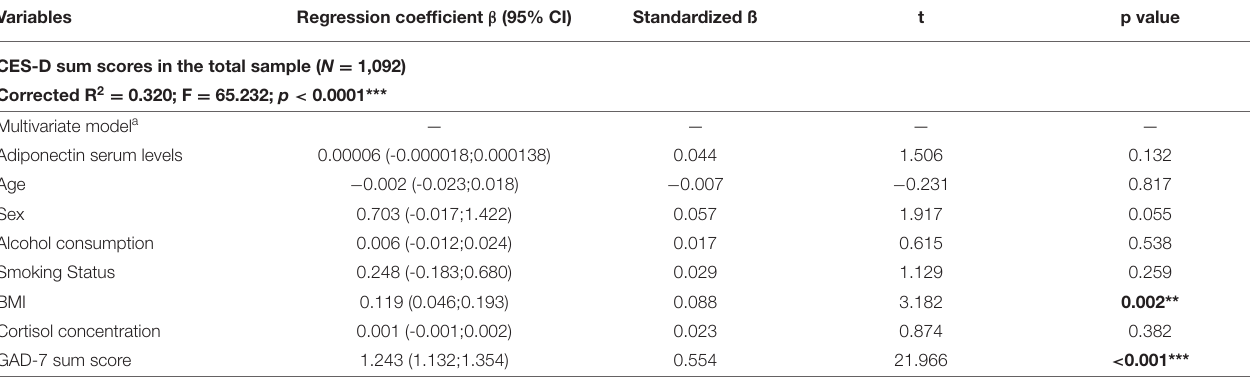
TABLE 3 | Results of multiple linear regression analyses regarding the association between adiponectin serum levels and CES-D sum scores reflecting the intensity of depressive symptoms in participants of the study.